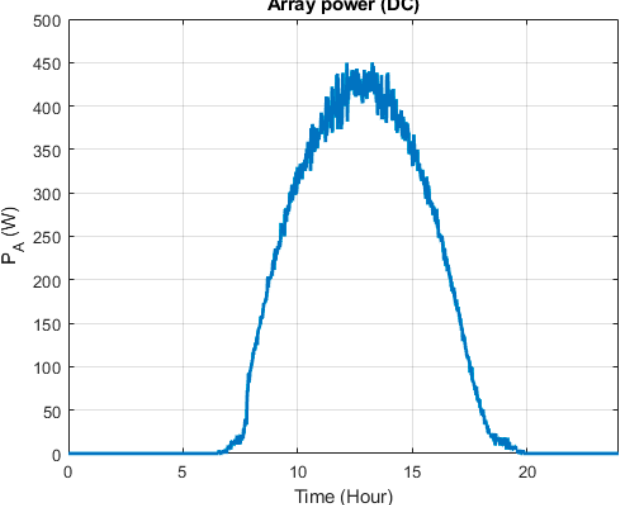
Figure 9. Array power, P A on a September day.